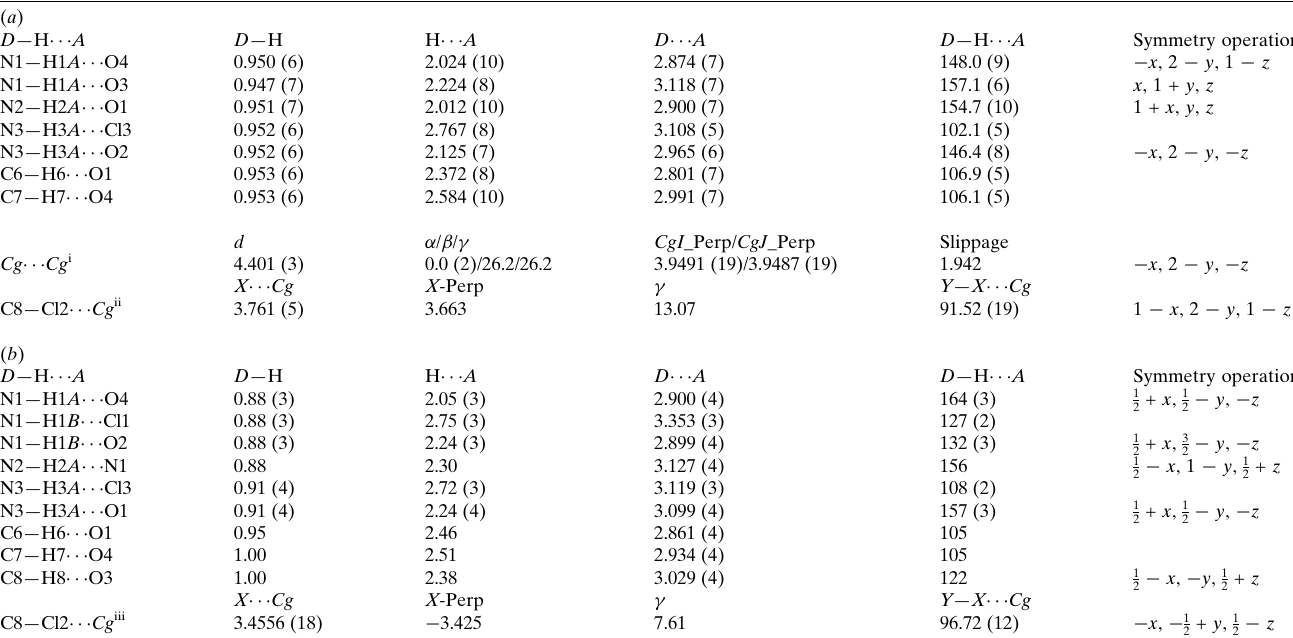
Table 1 Geometry (A˚ , (cid:3) ) of hydrogen bonds, (cid:3) – (cid:3) , and C—Cl (cid:2)(cid:2)(cid:2) (cid:3) interactions in ( a ) RS -TCMZ and ( b ) S-TCMZ (KIKCUD). Cg is the centroid of the C1–C6 ring. ( a ) D —H (cid:2)(cid:2)(cid:2)